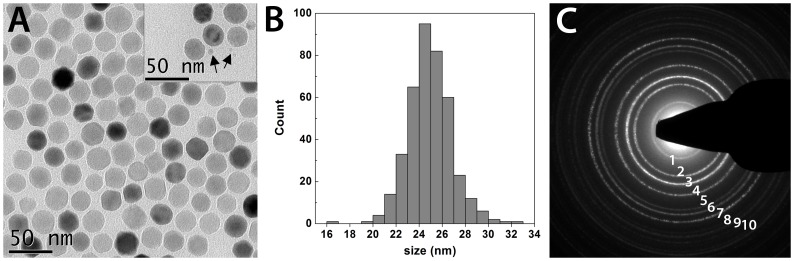
Transmission electron microscopy analysis of the IONs.(A) Typical TEM micrograph of the IONs; inset shows occasional presence of a subset of particles with a smaller diameter (arrows). (B) Size distribution profile of the IONs obtained from TEM analysis of 400 nanoparticles. (C) Selected area electron diffraction (SAED) pattern acquired from IONs.